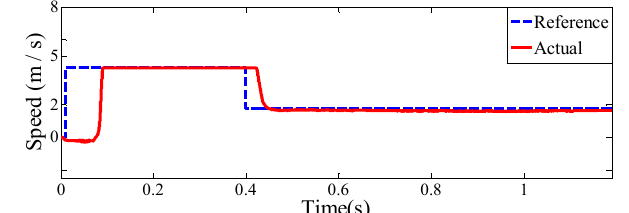
Fig. 5. Speed reference signal and speed actual of the motor by the proposed sliding mode observer.